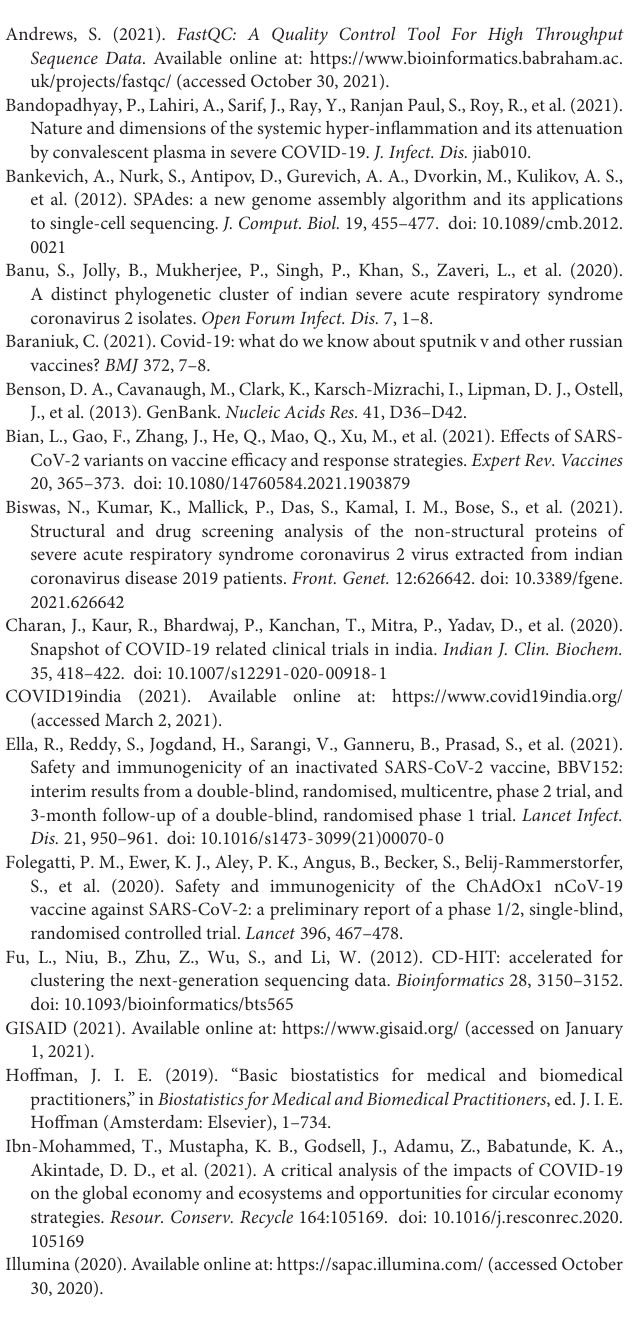
Supplementary Figure 5 | Dynamics of the co-mutation pattern across three terms for the most prevalent GISAID clades in India. The overlap of co-mutation patterns in three “Terms” for co-mutations having mutations between ≥ 3 and ≤ 5 sequences (A) and for > 5 co-mutations per sequence (B) is shown. Supplementary Figure 6 | Association of specific mutations with the status of the COVID-19 patients from India, Europe, and North America infected with specific clades of the SRAS-CoV-2 virus. A heat map of mutations and their frequencies that were found to be associated with four different categories of the